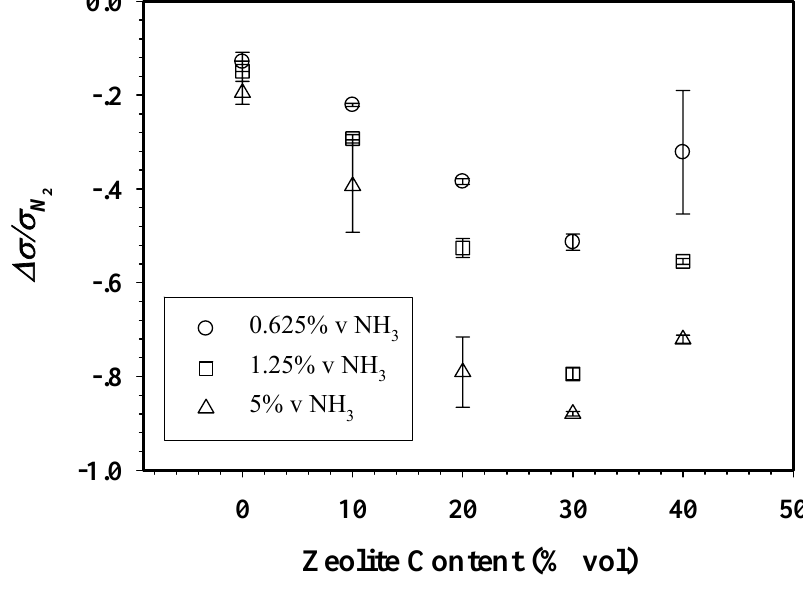
Figure 6. Proposed interaction between 50:1 dPPP and NH